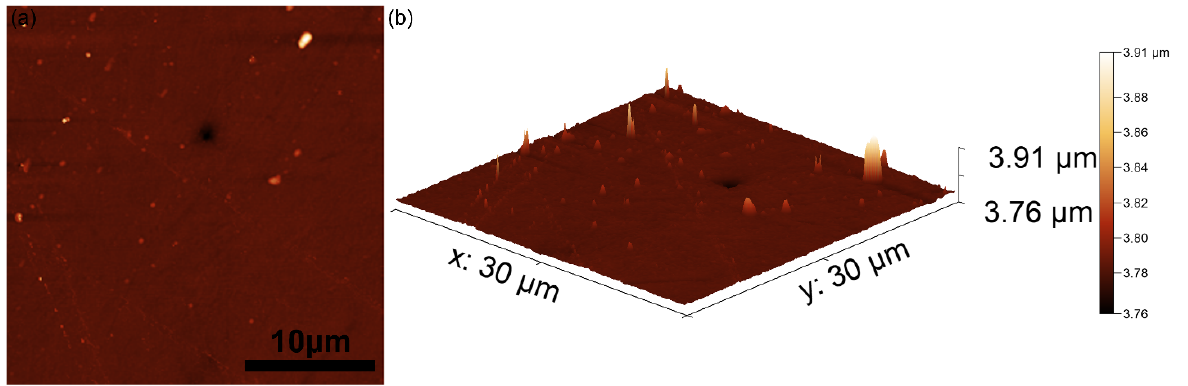
Figure 4. A 2D atomic force microscopy (AFM) topography image of PANI-IO thin films’ surface ( a ) and 3D representation of the surface topography of PANI-IO thin films’ surface ( b ).